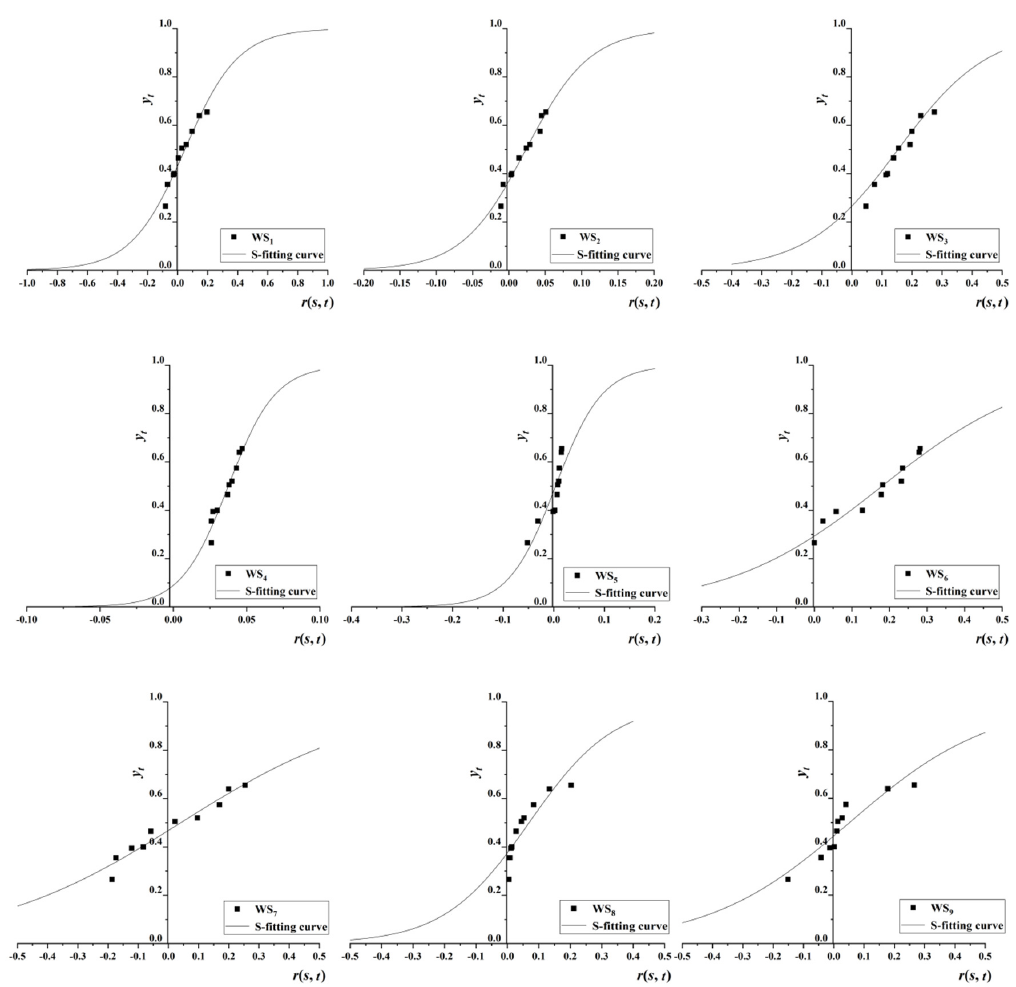
Figure 4. S-curves of r ( s , t ) and y t for EWS-RWRCC in Anhui Province.